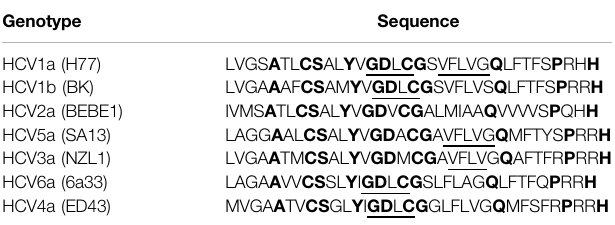
TABLE 6 | Alignment of segment 314 – 342 from various genotypes of HCV (Spadaccini et al., 2010). In bold are represented the highly conserved residues. In red and blue are the α -helices (319 – 323) and (329 – 338) respectively. Genotype